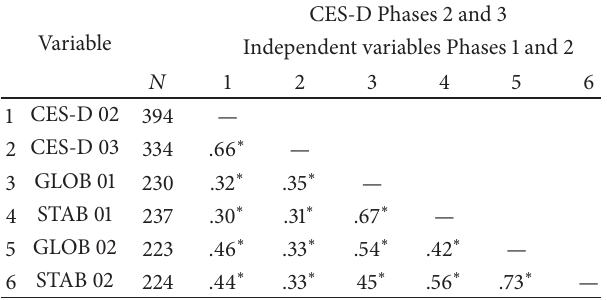
Table 2: Longitudinal Correlational Matrix for Independent Vari- ables at Phases 1 and 2 with depressive symptoms at Phases 2 and 3.